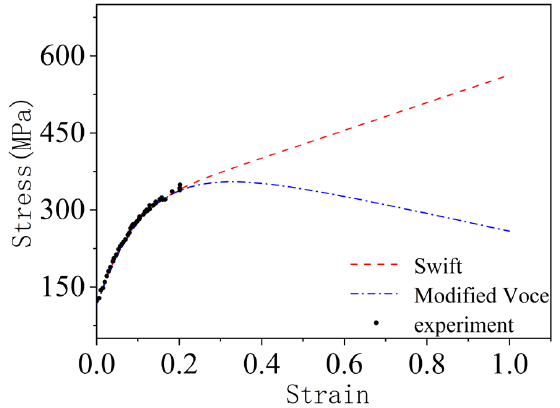
Figure 23. Stress-strain curve of material AA5182.